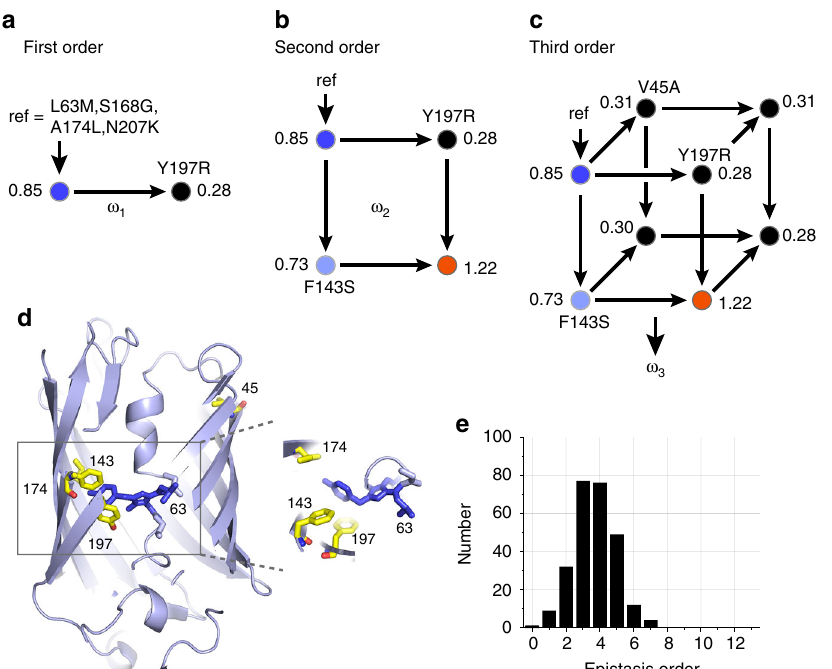
Fig. 2 High-order epistasis in the sequence variations linking mTagBFP2 and mKate2. For illustration, panels a – c show the single reference form of epistasis taking an arbitrary genotype as the background (ref = L63M/S168G/A174L/N207K); circles indicate fl uorescence color. All other panels indicate background-averaged epistasis. a First-order epistasis is simply the effect of a single mutation. For example, in the reference background, Y197R shows ω = 0.28 – 0.85 = − 0.57, indicating loss-of-function. b Second order epistasis is the dependence of a fi rst order term on a second mutation. Here, Y197R 1 has a completely different effect in the background of F143S, and thus these two mutations display a large second order term ( ω 2 = 1.06). c Third-order epistasis is the dependence of a second order term on a third mutation. Here, the pairwise epistasis of Y197R and F143S is quenched in the background of V45A, indicating a large third-order term ( ω 3 = − 1.07). d Positions involved in large epistatic interactions are shown, indicating sites both proximal and distal to the chromophore. e The distribution of the 260 statistically signi fi cant background-averaged epistatic terms (threshold, P < 0.01), showing a